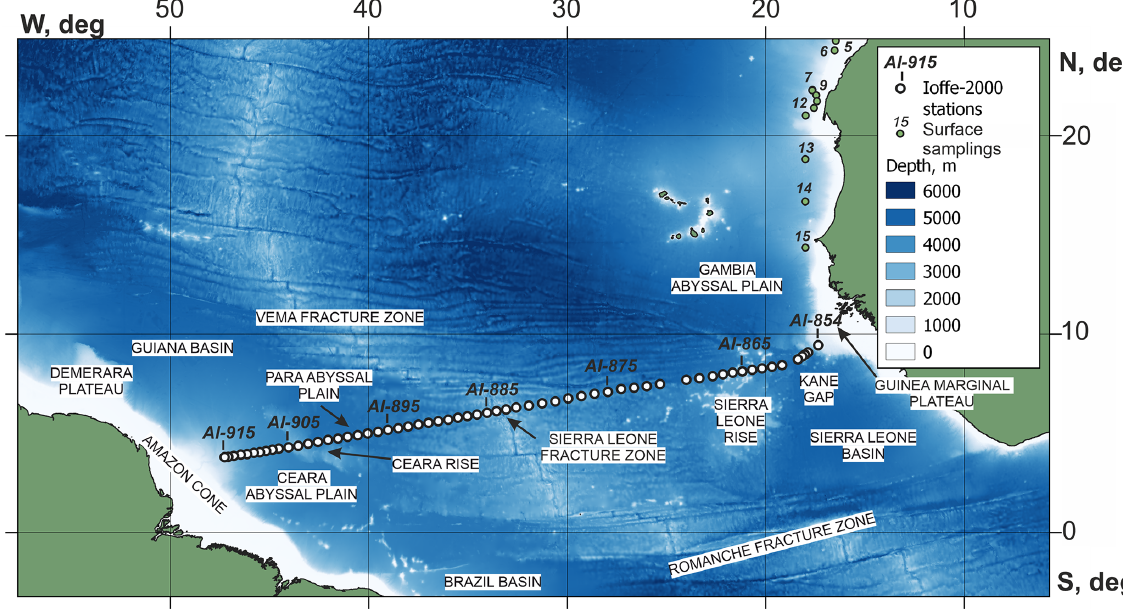
Figure 1. The Ioffe-2000 transect position in the study area (station numbers, every 10 stations). Bottom topography taken according to the GEBCO Bathymetric Compilation Group